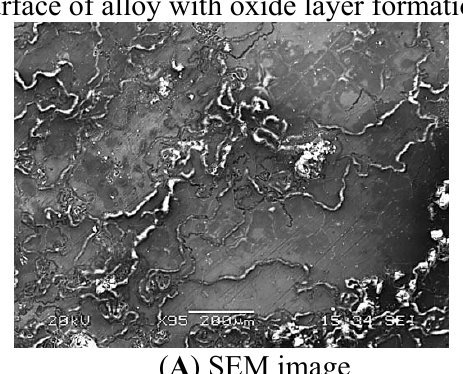
Figure 2. SEM images and XPS analysis of oxide layer formation on the Mg-Zn-Cu alloy. surface of alloy with oxide layer formation surface of alloys without oxide